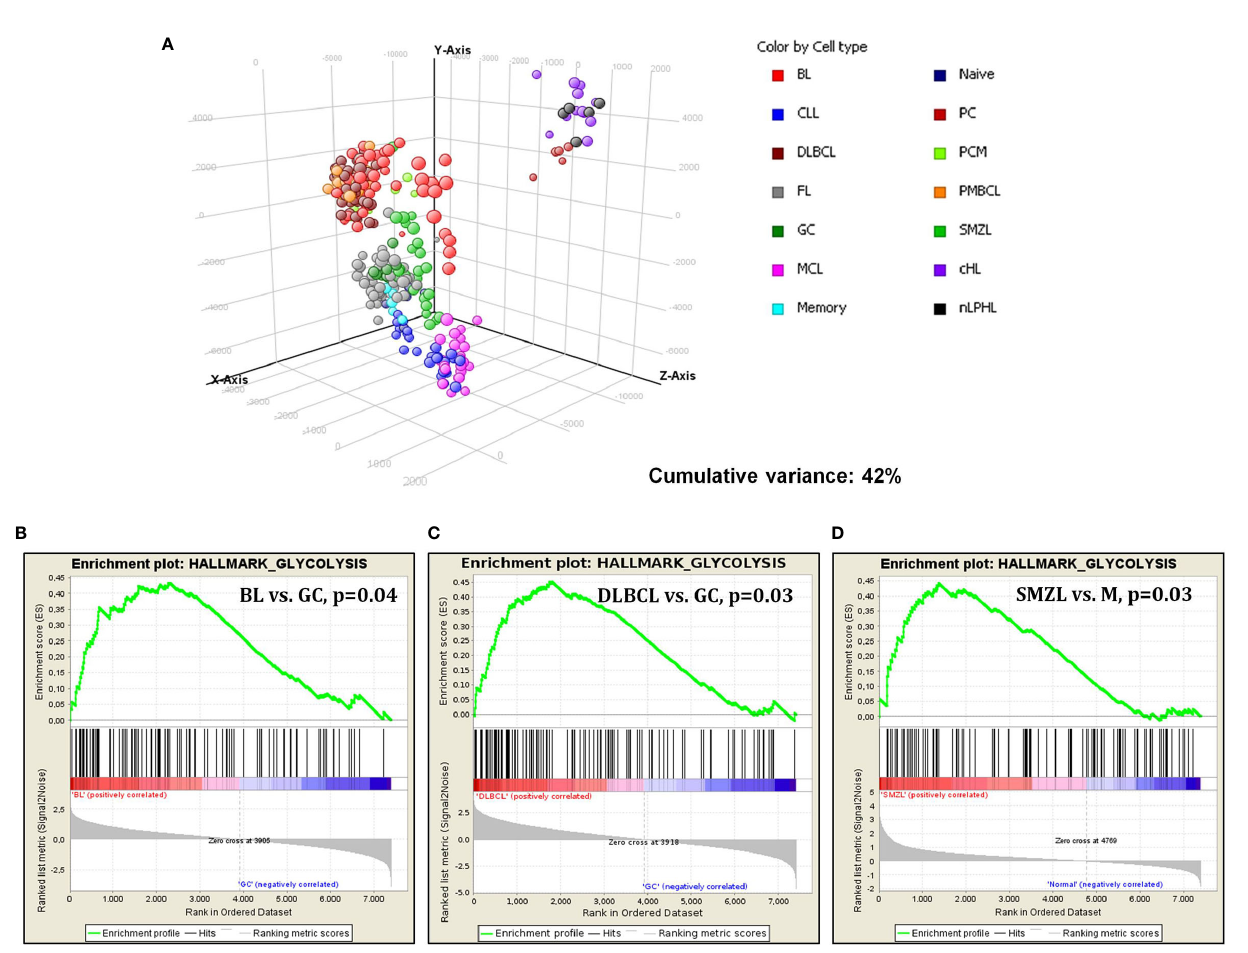
FIGURE 2 | Gene expression analysis of lymphomas and normal B-cell by DNA microarrays. (A) PCA showed speci fi c clustering of lymphomas and normal cells based on glucose metabolism associated genes. Each sphere represents a sample. (B – D) GSEA revealed signi fi cant enrichment in genes involved in glycolysis in BL, DLBCL and SMZL, when these tumors were confronted to their normal